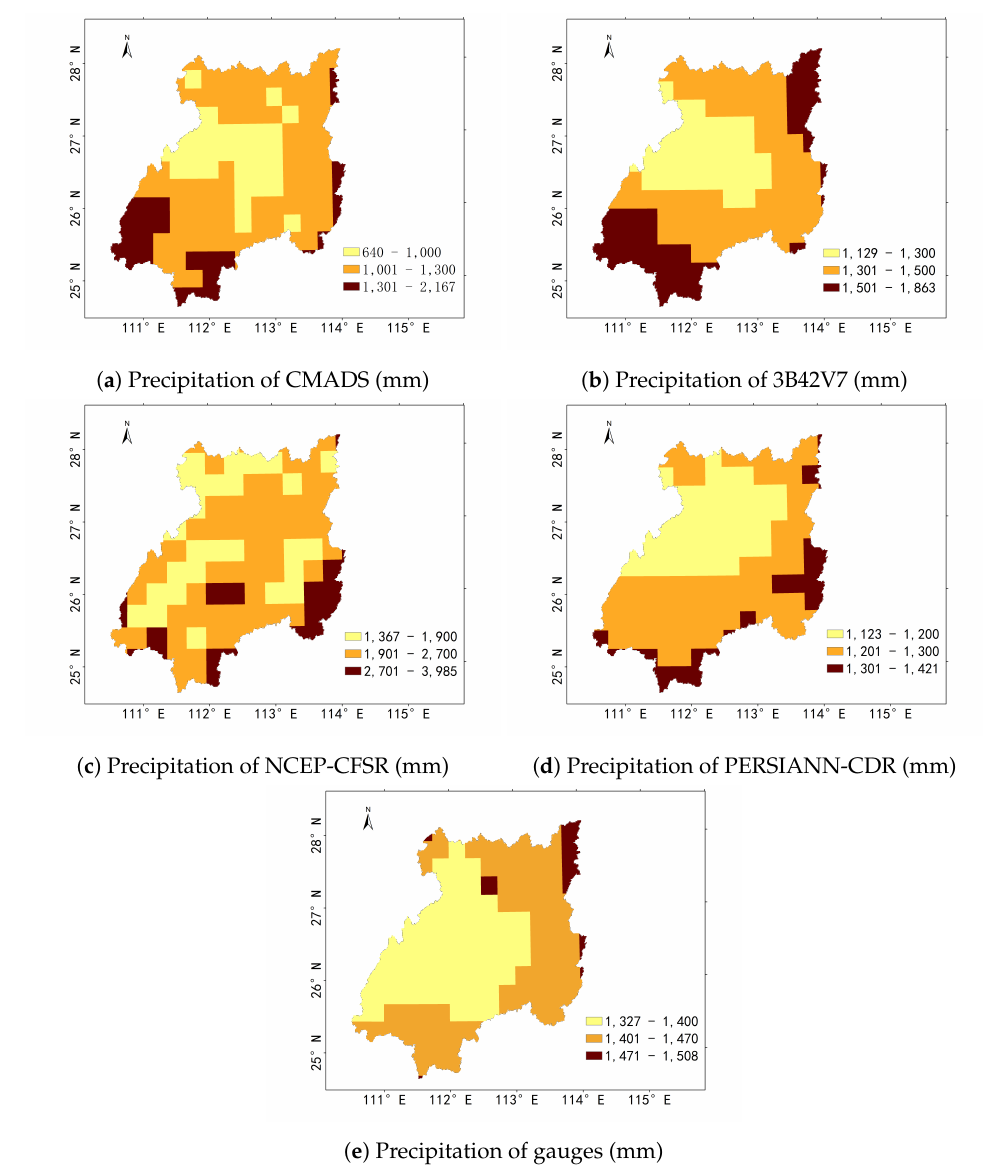
Figure 2. Spatial distribution of annual precipitation